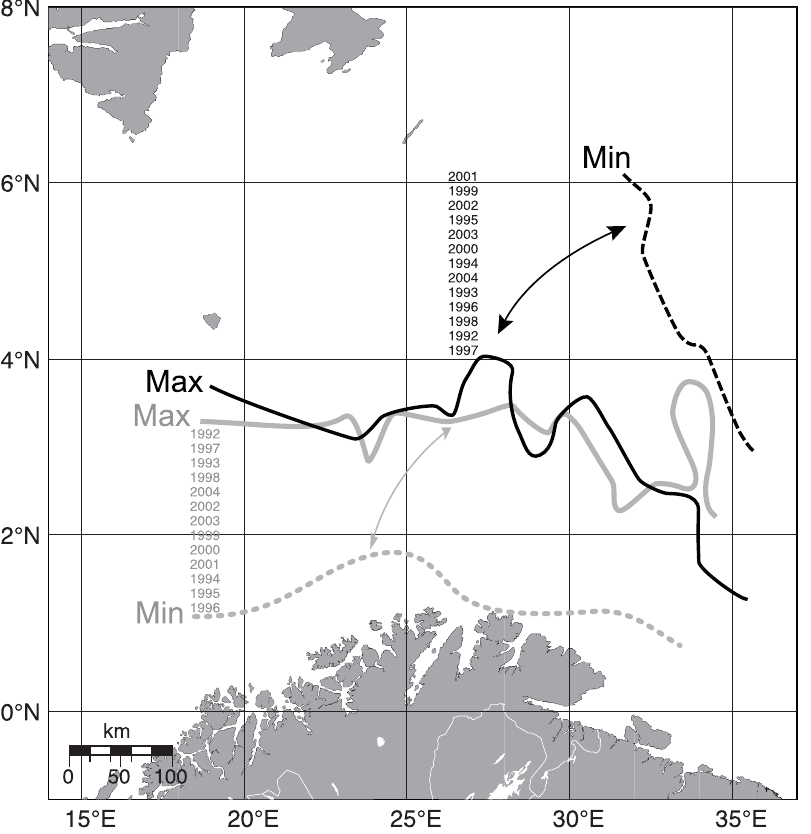
Figure 4. Distribution of assemblages. Maximum and minimum distribution of the cold water NE assemblage ( Artediellus atlanticus, Leptagonus decagonus , Leptoclinus maculates and Lumpenus lampraetaeformis ) in black and the warm water S assemblage ( Argentina silus , Pollachius virens and Trisopterus esmarkii ) in grey. Max indicates the widest distribution of respective assemblage (area where $ 10 individuals of the key species group have been observed over time), and Min indicates the narrowest annual distribution of both key species groups in 1992 to 2004. The ranks of years indicate the position of the maximum and the minimum distribution of the S and NE assemblages each year.